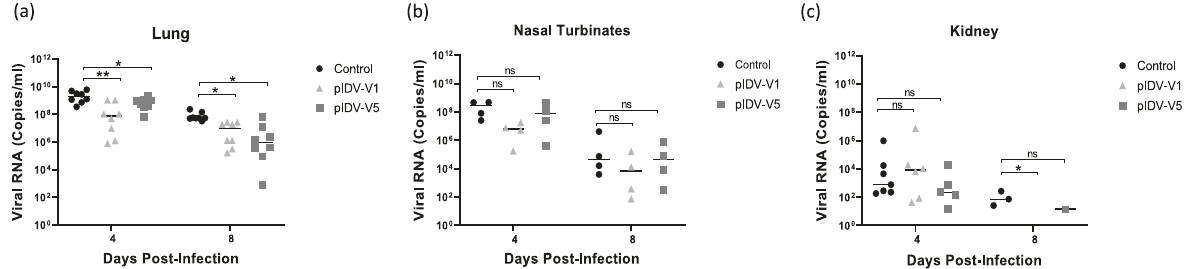
Fig. 5 Comparison of SARS-CoV-2 viral load in different tissues. a Viral RNA load (mean [SD]) from hamster lung samples in control, PIDV-V1, and PIDV-V5 groups at day 4 and day 8 post-infection. Two-way- ANOVA- Dunnett ’ s multiple comparisons test was performed (Control vs. PIDV-V1 day 4, ** p = 0.0091, Control vs. PIDV-V5 day 4 * p = 0.0457, Control vs. PIDV-V1 day 8, * p = 0.0101, Control vs. PIDV-V5 day 8 * p = 0.0119). b Viral load from hamster nasal turbinate samples in control, PIDV-V1, and PIDV-V5 groups at day 4 and day 8 post-infection. Two-way- ANOVA- Dunnett ’ s multiple comparisons test was performed (Control vs. PIDV-V1 day 4, p = 0.1393, Control vs. PIDV-V5 day 4 p = 0.5203, Control vs. PIDV-V1 day 8, p = 0.3616, Control vs. PIDV-V5 day 8 p = 0.4596). c Viral load from hamster Kidney samples in control, PIDV-V1, and PIDV-V5 groups at day 4 and day 8 post-infection. Two-way- ANOVA- Dunnett ’ s multiple comparisons test was performed (Control vs. PIDV-V1 day 4, p = 0.3591, Control vs. PIDV-V5 day 4 p = 0.3768, Control vs. PIDV-V5 day 8 p = 0.3432). For all panels, error bars represent the standard deviation.